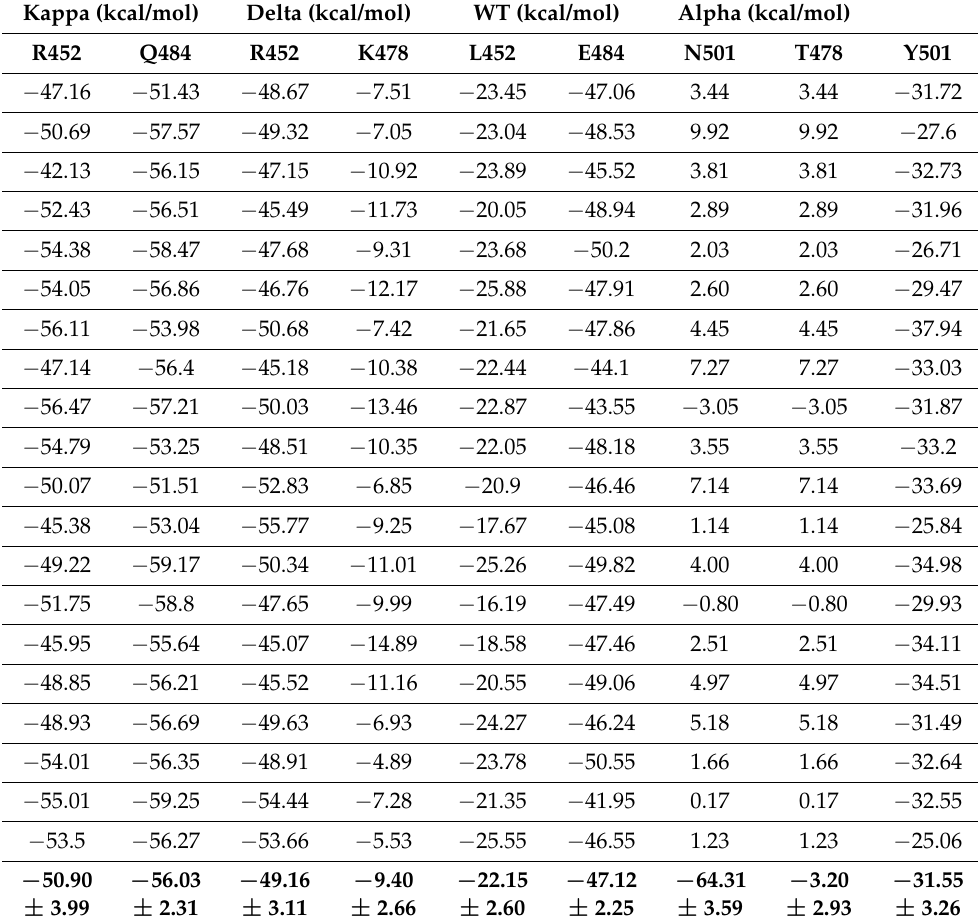
Table 1. Residue wise energy contribution of the mutated residues compared with the wildtype for the twenty structures extracted from 50 to 200 ns of the simulation for all the three